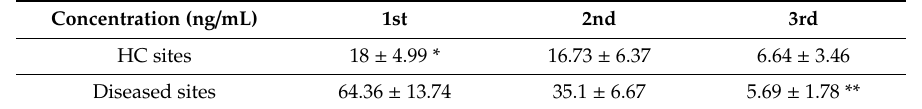
Table 2. Changes in the concentrations of HSP70 in GCF collected from HC and diseased sites during the periodontal